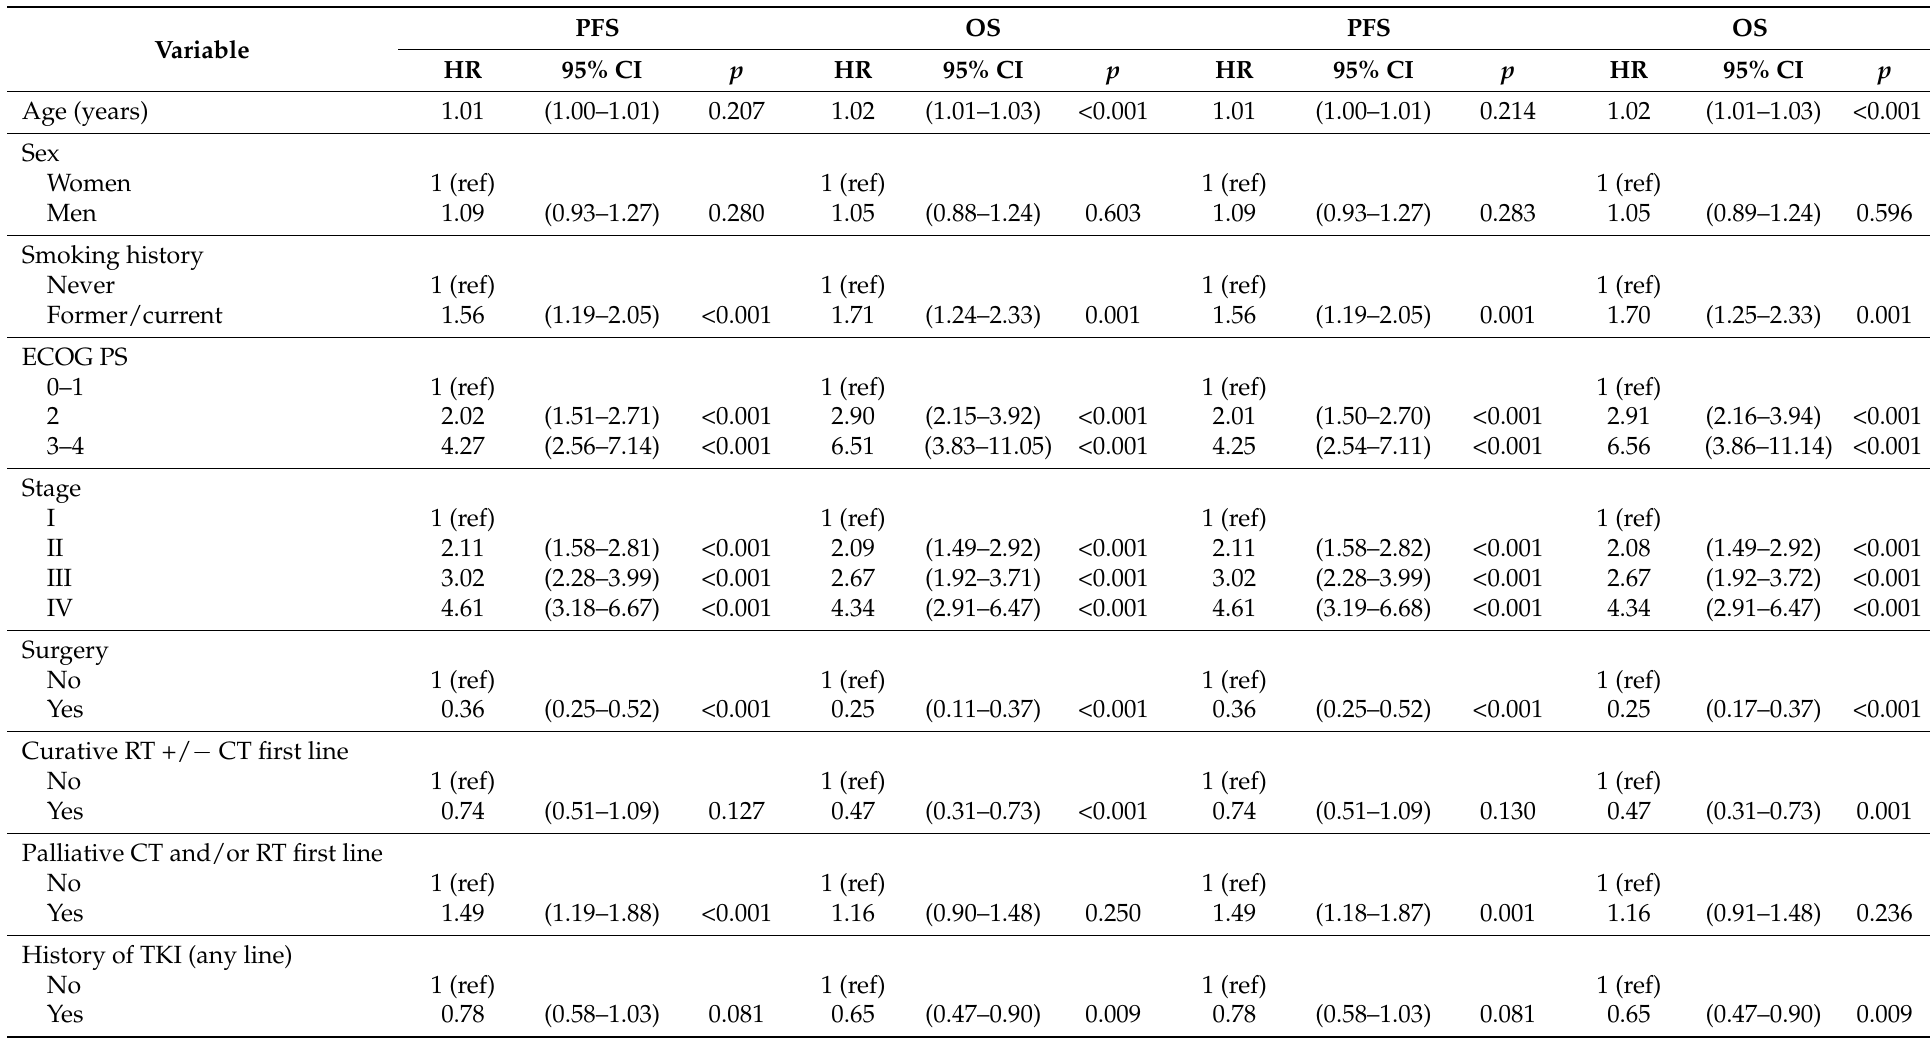
Table 3. Multivariable analyses of progression free survival and overall survival in patients st. I–IV with KRAS wild type, KRAS mutated, KRAS G12C, and KRAS non-G12C mutated